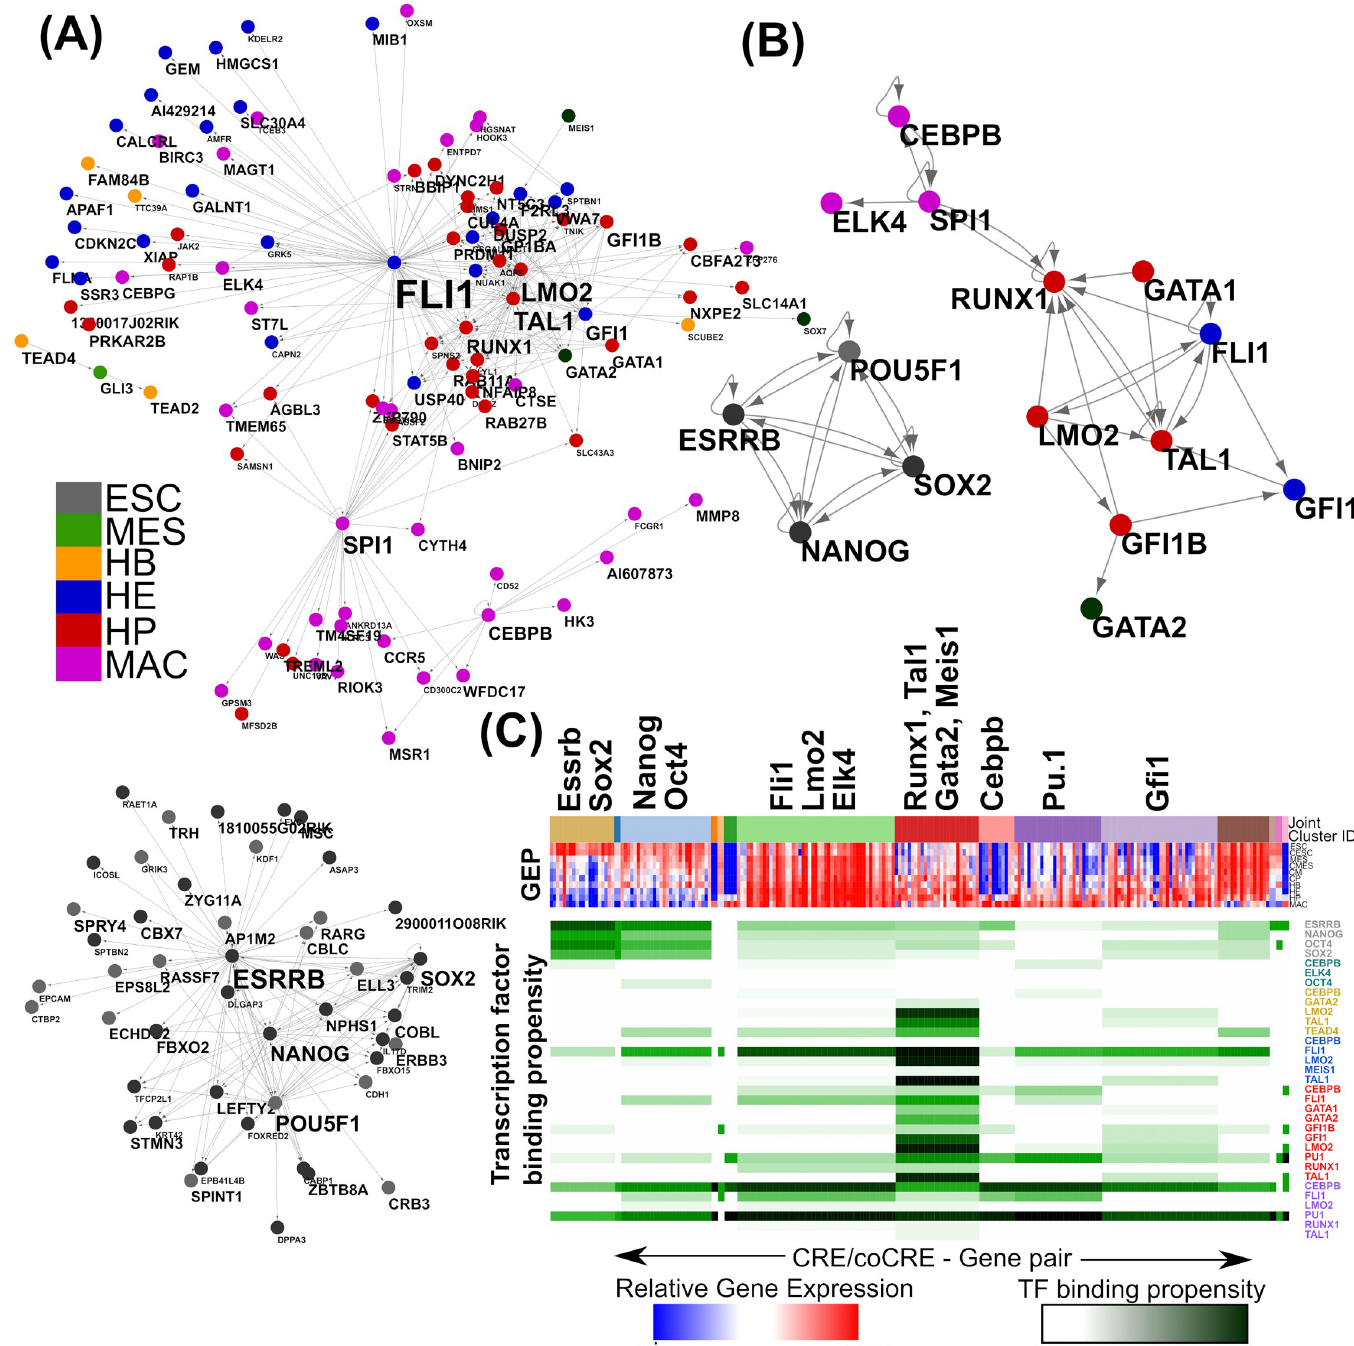
Fig 5. Cis regulatory networks (CRNs) and joint clustering of expression and regulation. (A) CRN for the TF cluster set. The genes are represented as nodes and directed edges show the genes that are co-expressed and also bound by the TF of one gene (source) to a predicted CRE of the other gene (target). The cell type at which the expression of the gene is highest is shown as colours on the node. The size of the node name is proportional to its degree. (B) The CRN for the TF set (colours as A). (C) Joint clustering of genes in the TF cluster set. Genes cluster together according to the relatedness of both gene expression patterns (red-blue heatmap) and the binary pattern of TF binding (green-white heatmap) at their main predicted (co)CRE. Each cluster is distinguished by a colour coded bar above the GEP heatmap (highlighted as “Joint cluster ID”). For each cluster, the average of the TF binding profile is shown as the TF binding propensity, where 0 represents absence of TF binding and 1 represents binding of that specific TF in all the regions belonging to that cluster (green = TF binding; white = no TF binding).